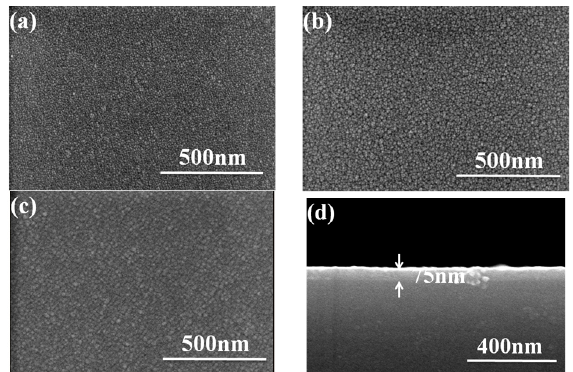
Figure 1. Surface morphology and cross observations of Nb 2 O 5 thin film deposited at ( a ) room temperature (RT), ( b ) 300 °C, and ( c ) 400 °C, respectively. ( d ) Cross-section observation of Nb 2 O 5 thin films, the deposition temperature was 200 °C and the O 2 ratio was 10%, respectively.